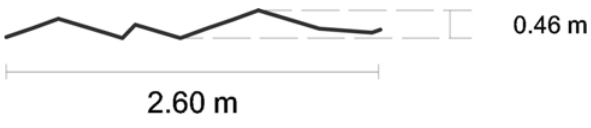
Fig.5: Cross sections drawn perpendicular to the road axis with automatic processes Analysis conducted on sections drawn was measured for each of them the difference between the point at higher levels and the one smaller share (in section 1 of 0.66 meters, the first, in